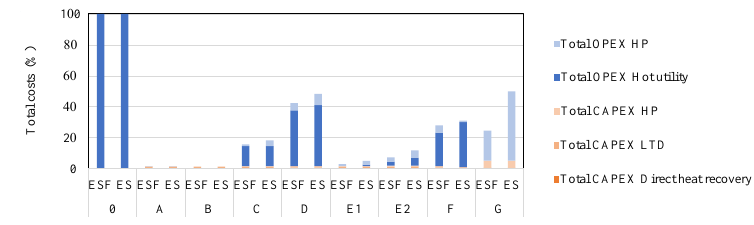
Figure 12. Total costs for heat recovery measures and steam supply.